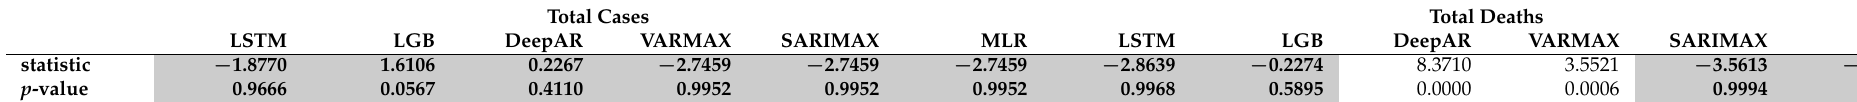
Table 15. Student’s t-test for Prediction Interval Coverage (H 0 : Benchmark Prediction Intervals Outperform